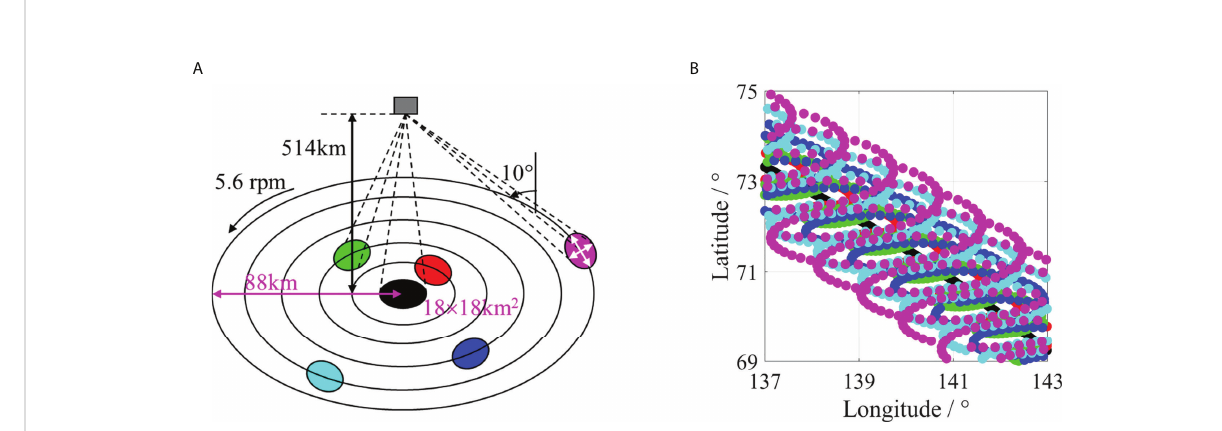
FIGURE 1 SWIM detection schematics for six incidence beams. (A) The projection geometries of the six beams in one macrocycle. One macrocycle represents six successive beams transmitting at small incidence angles with a discontinuous azimuth. (B) Samples of several macrocycles over the Earth ’ s surface (antenna aperture: